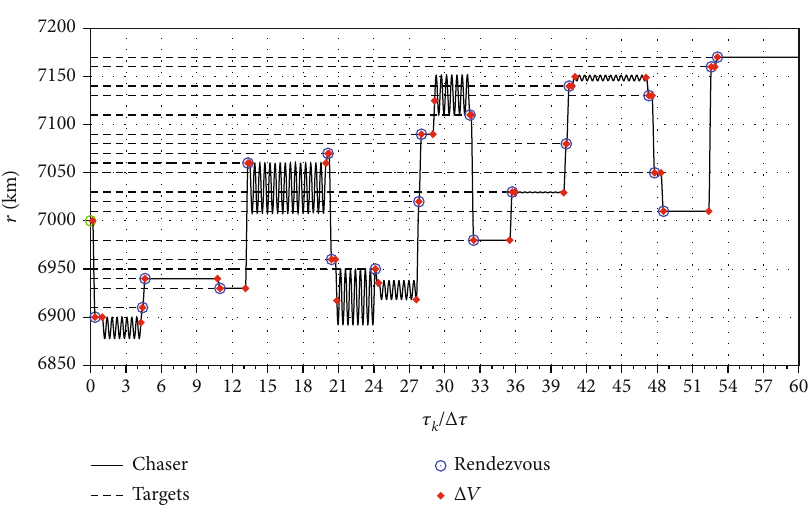
Δτ for the 20 × 3 k /